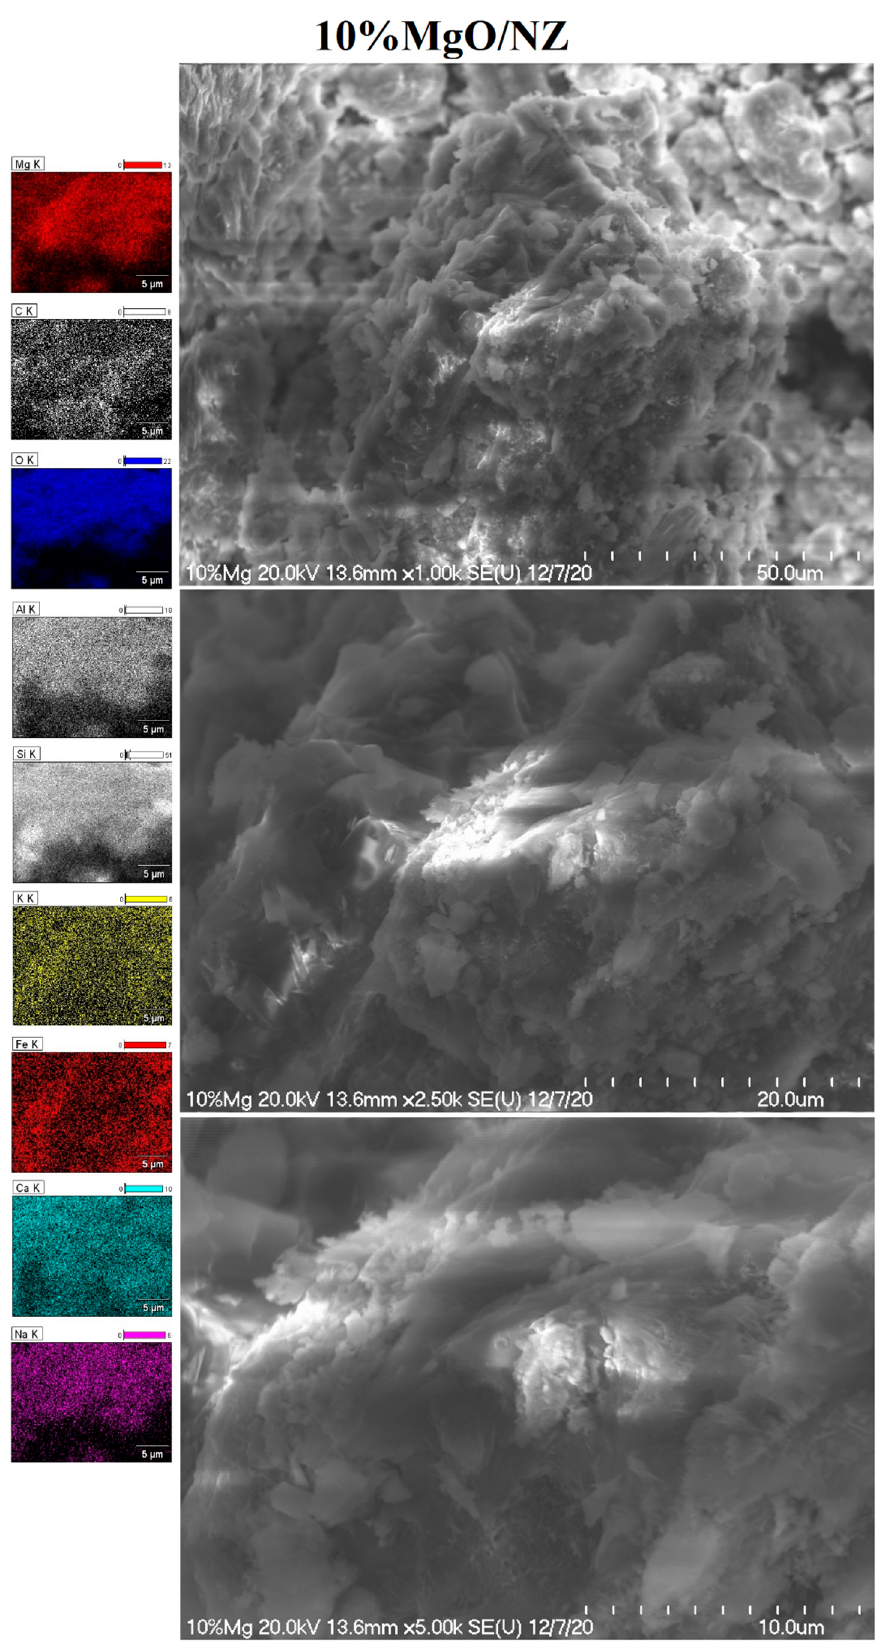
Figure 4. SEM-EDS images of the calcined metal oxide 10% MgO/NZ catalyst in an air atmosphere at 400 °C for 4 h.